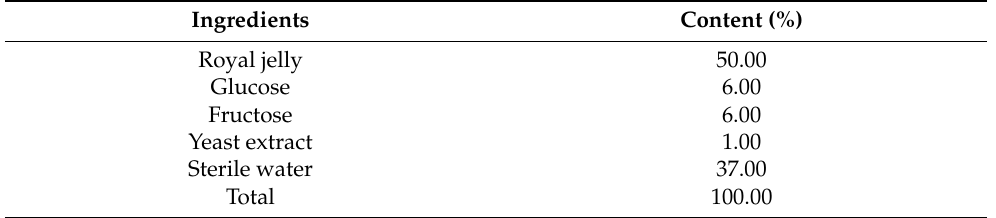
Table 2. Composition of larvae diets. Ingredients Content (%) Royal jelly 50.00 Glucose 6.00 Fructose 6.00 Yeast extract 1.00 Sterile water